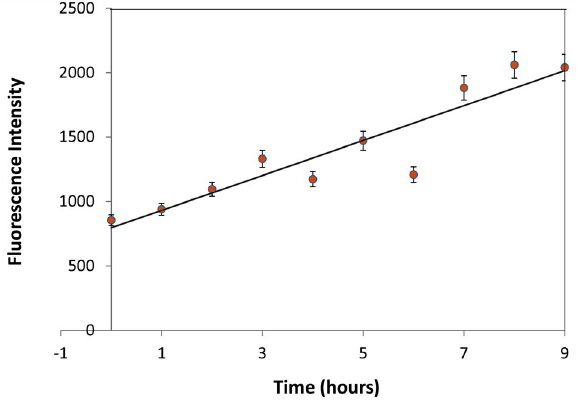
Figure 5. Thioflavin-T Assay of lysozyme upon transformation into amyloid fibril structures